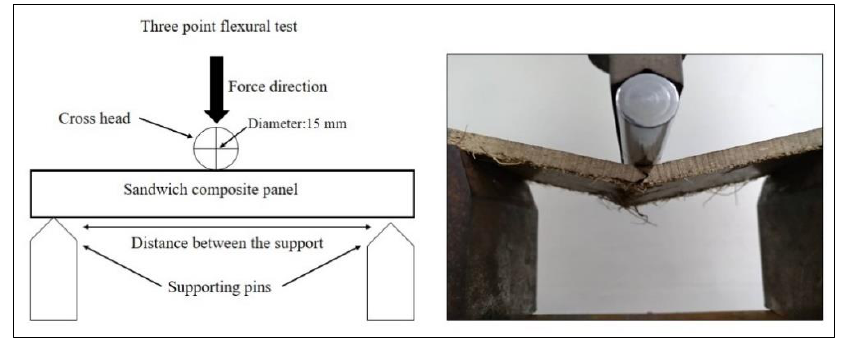
Figure 3. Three-point bending testing on the sandwich composite panel sample.